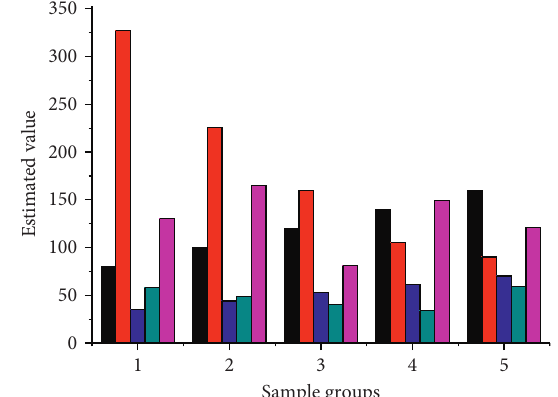
Figure 3: The distribution of image sequence parameter